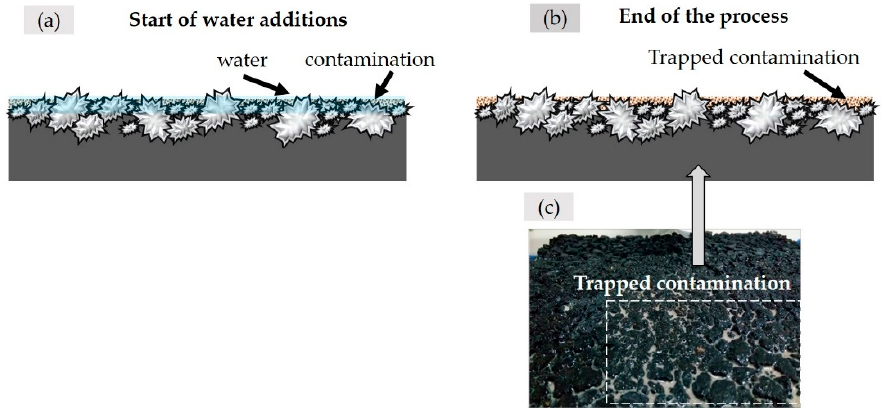
Figure 19. Wetting process: ( a ) start, ( b ) end and ( c ) slab status at the end of wetting process.